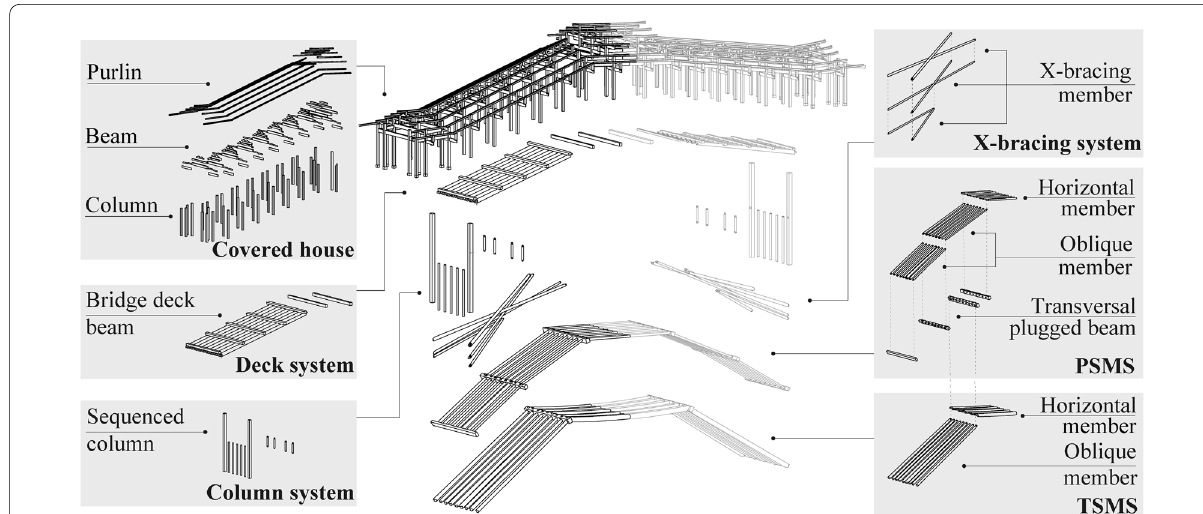
Fig. 3 Structural components of a typical timber arch lounge